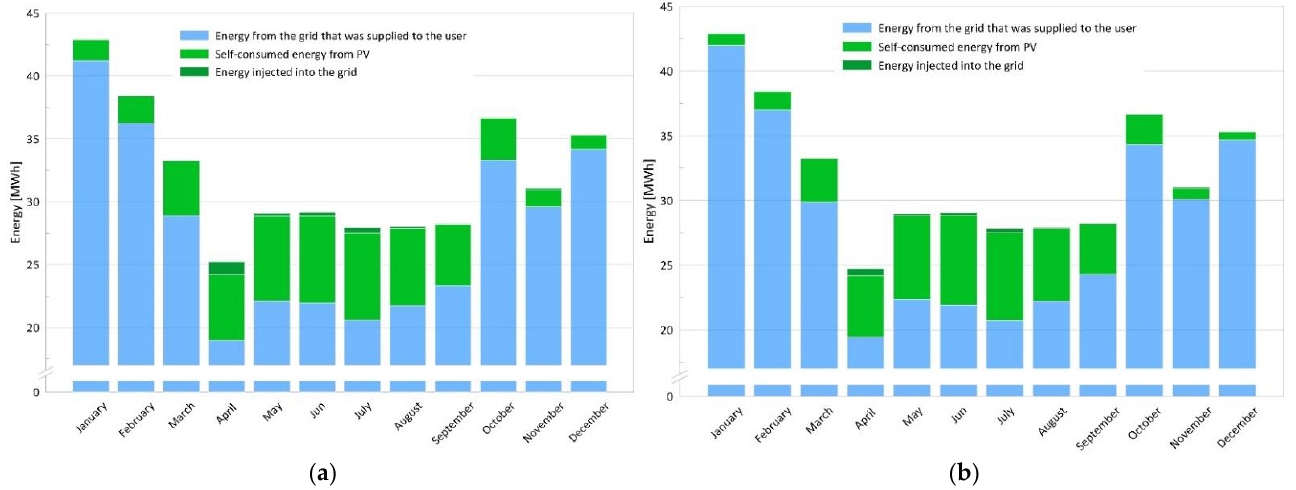
Figure 4. Comparison of the company monthly energy distribution for a PV system facing South ( a ) and East – West ( b ).